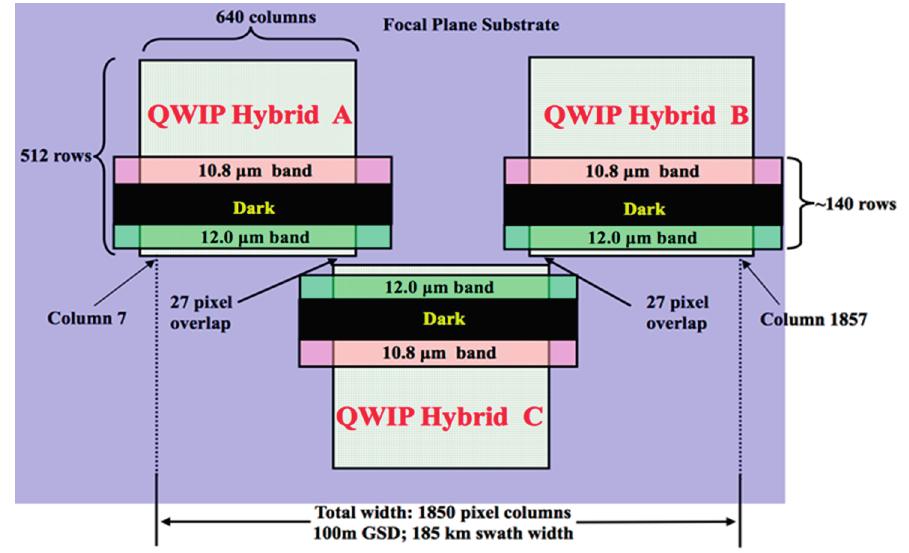
Figure 6. Focal plane layout schematic showing the infrared band locations on the QWIP arrays. The dark area between the filters eliminates scattering between the bands. The first and last seven columns of each array are not used to form the swath. Between that and the fact that there is an overlap area on the ground “seen” by each array, the 1920 total row pixels (3 × 640) are reduced to 1850 pixels.2.2.